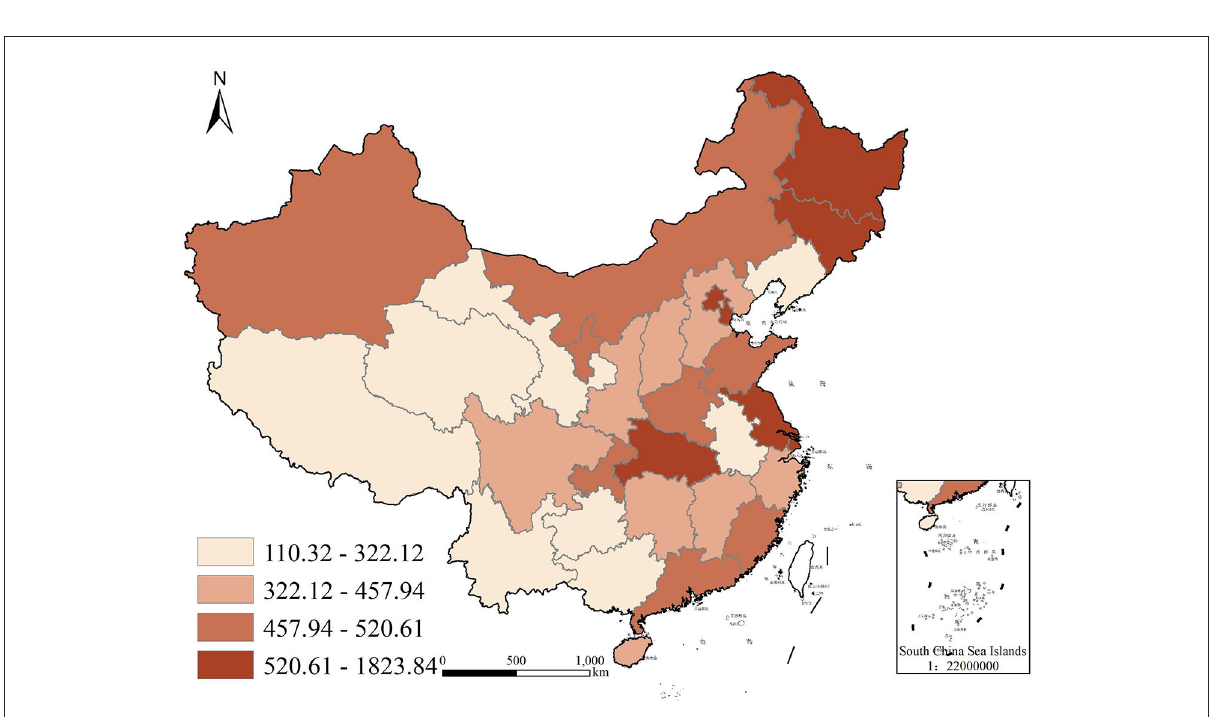
FIGURE3 Commercial health insurance density in China in